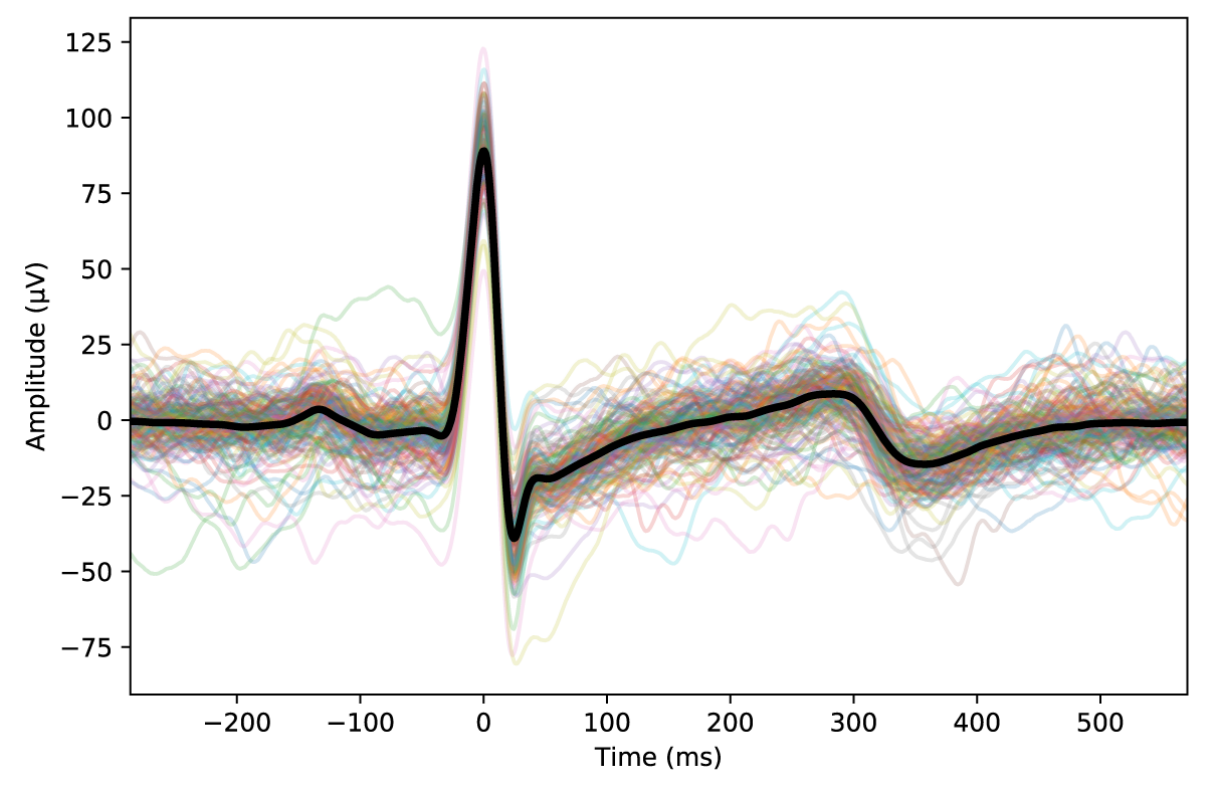
Figure 4. Ensemble averaging aligns multiple beats based on the R-wave peak location to calculate an average beat. Individual beats that passed all the rejection criteria are shown as thin light-colored lines, and the resulting ensemble averaged beat is shown as a thick dark